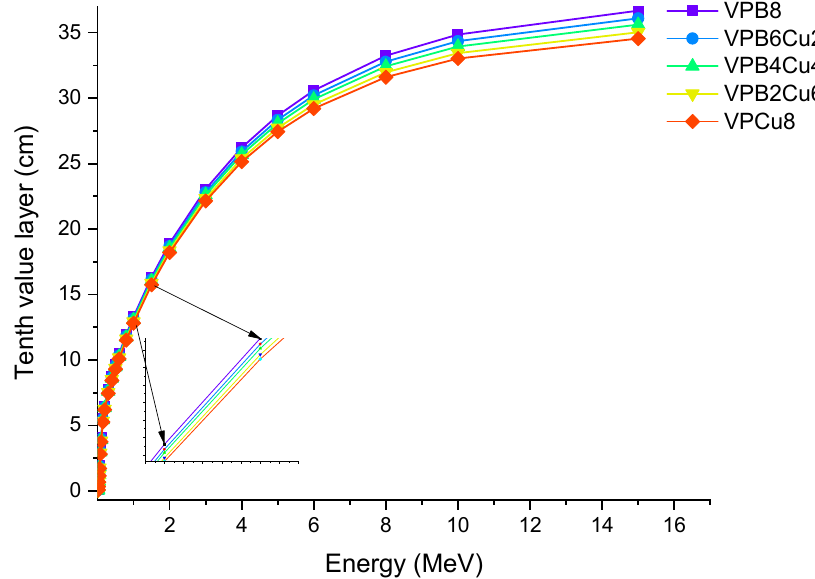
Figure 8. Variation of tenth value layer (T 1/10 ) against photon energy for VPB x Cu y glass samples.